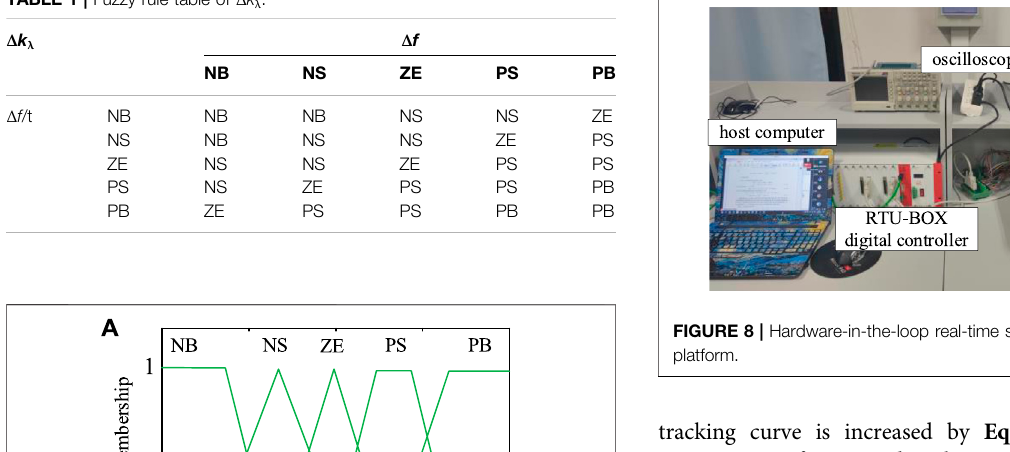
TABLE 1 | Fuzzy rule table of Δ k λ .